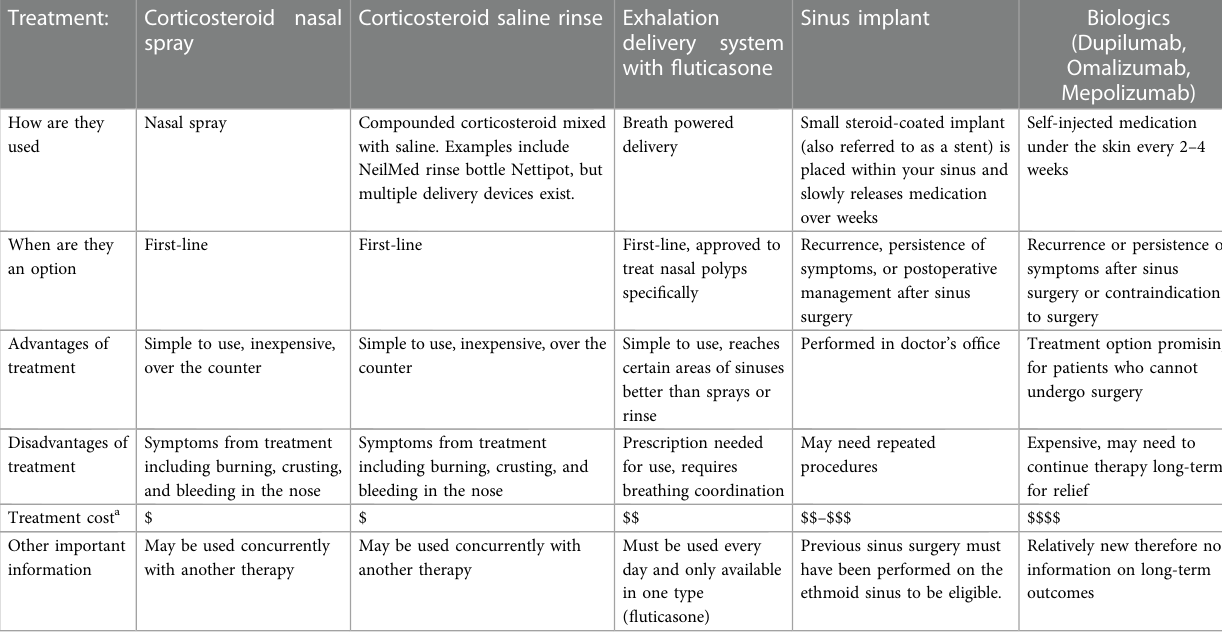
TABLE 1 Summary of the indications, advantages, disadvantages, cost, and other considerations for various treatment options for patients diagnosed with chronic rhinosinusitis with nasal polyps. Treatment: